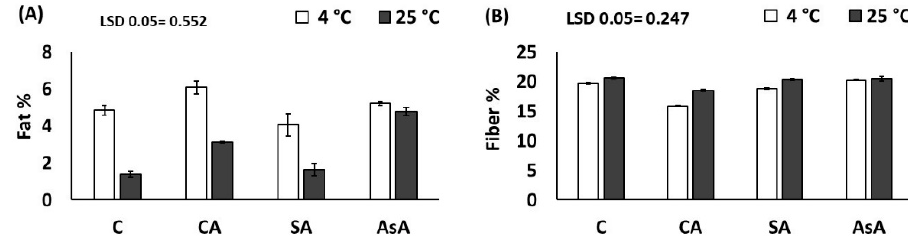
Figure 8. Effects of bio-stimulants B, control (C), citric acid (CA), salicylic acid (SA) and ascorbic acid (AsA) and storage temperature SP (4 °C and 25 °C) on fat % ( A ) and fiber % ( B ) of okra pods stored for 12 days. Error bars are the ±SD of the means of three biological replicates. LSD values ( p ≤ 0.005) for fat % ( A ): B = 0.39 and T = 0.28. LSD values ( p ≤ 0.05) for fiber % ( B ): B = 0.18 and T = 0.12. LSD for B ×T is displayed on the figure.